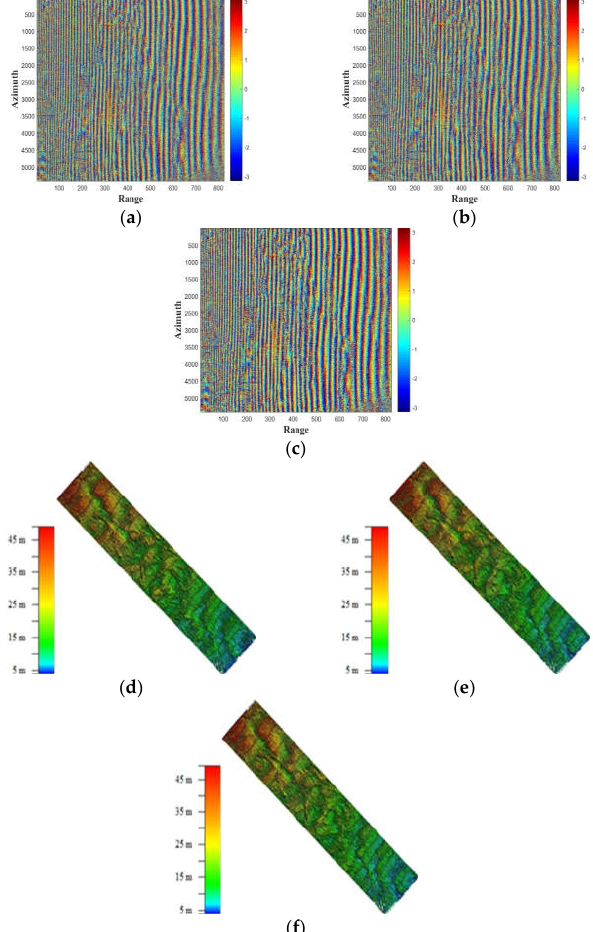
Figure 14. InSAR fringes and DEMs with different processing strategies. ( a ) NB MoCo-based fringe. ( b ) LOS MoCo-based fringe. ( c ) LOS MoCo-based DBF fringe. ( d ) NB MoCo-based DEM. ( e ) LOS MoCo-based DEM. ( f ) LOS MoCo-based DBF DEM